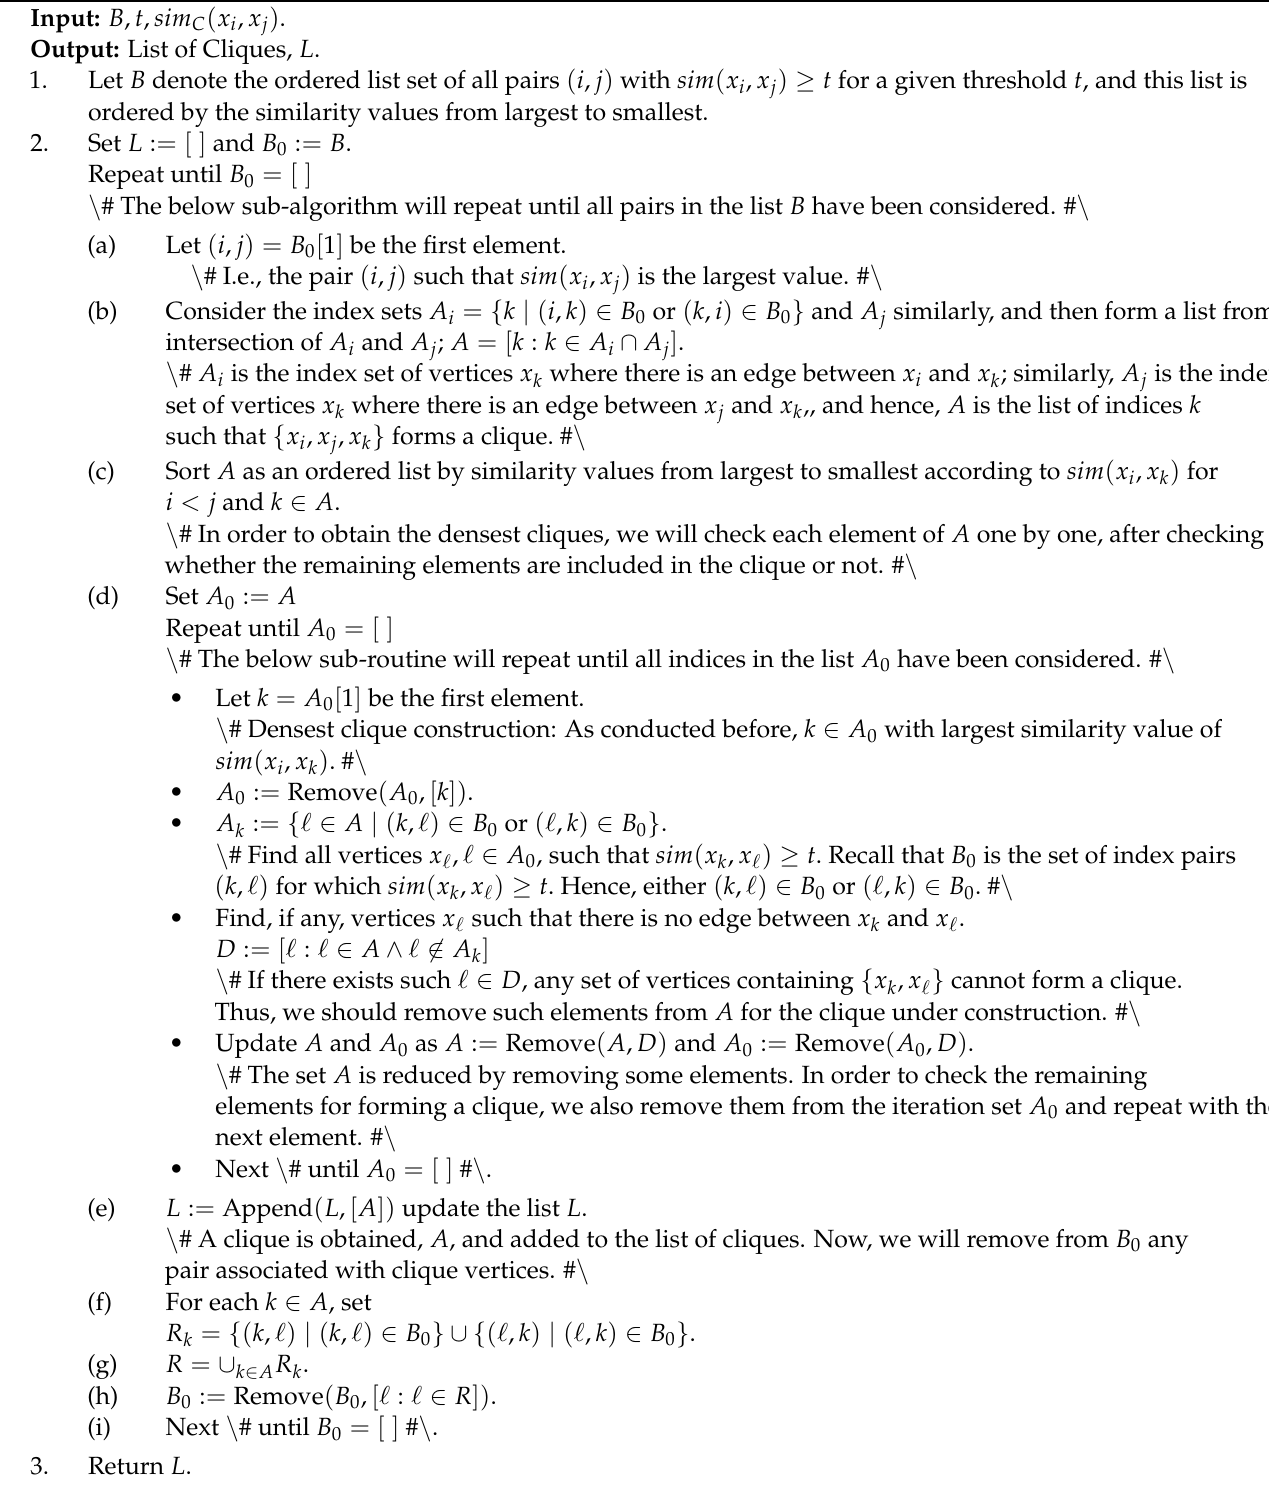
Algorithm 1: Clique Clustering (CC)